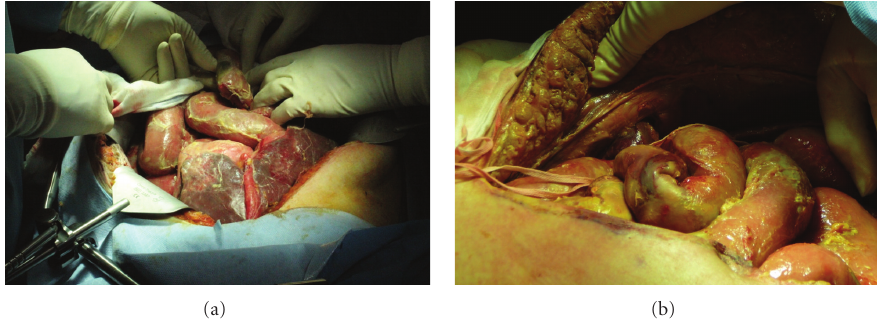
Figure 2: An emergency laparotomy revealed intestinal and colonic necrosis which necessitated a 100 cm resection of the terminal ileum and subtotal colectomy with terminal ileostomy (a). An abundant quantity of nonpurulent but foul-smelling fluid was recovered during the surgery. Thick yellowish membranes covering all intra-abdominal organs were also noticed during surgery (b).